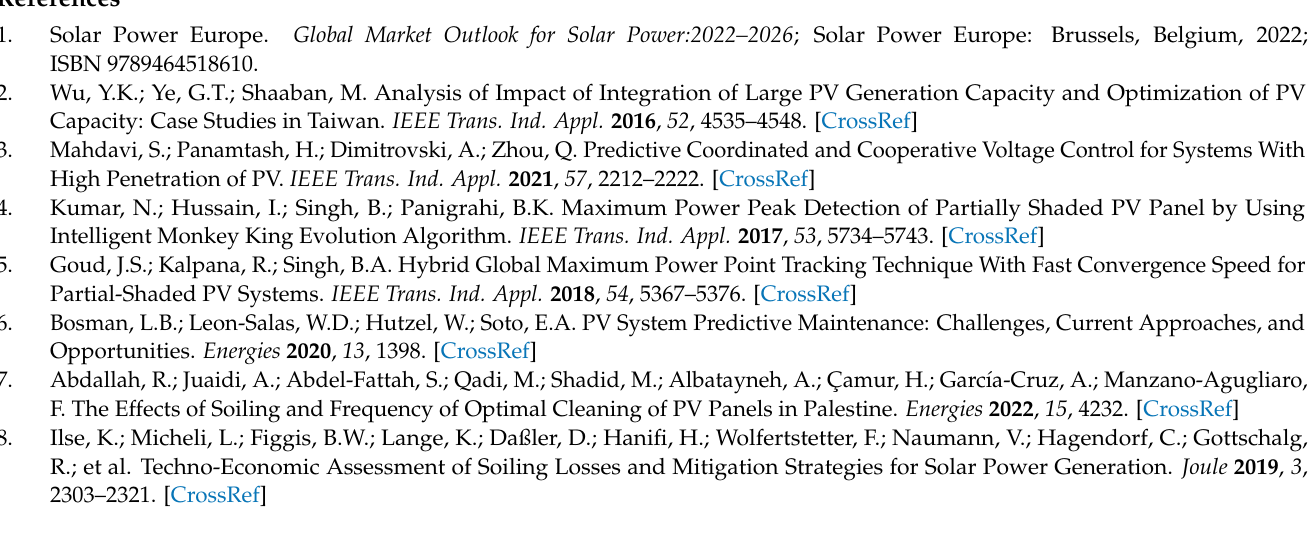
Figure A5. Soiling data from the power plant at location 5.